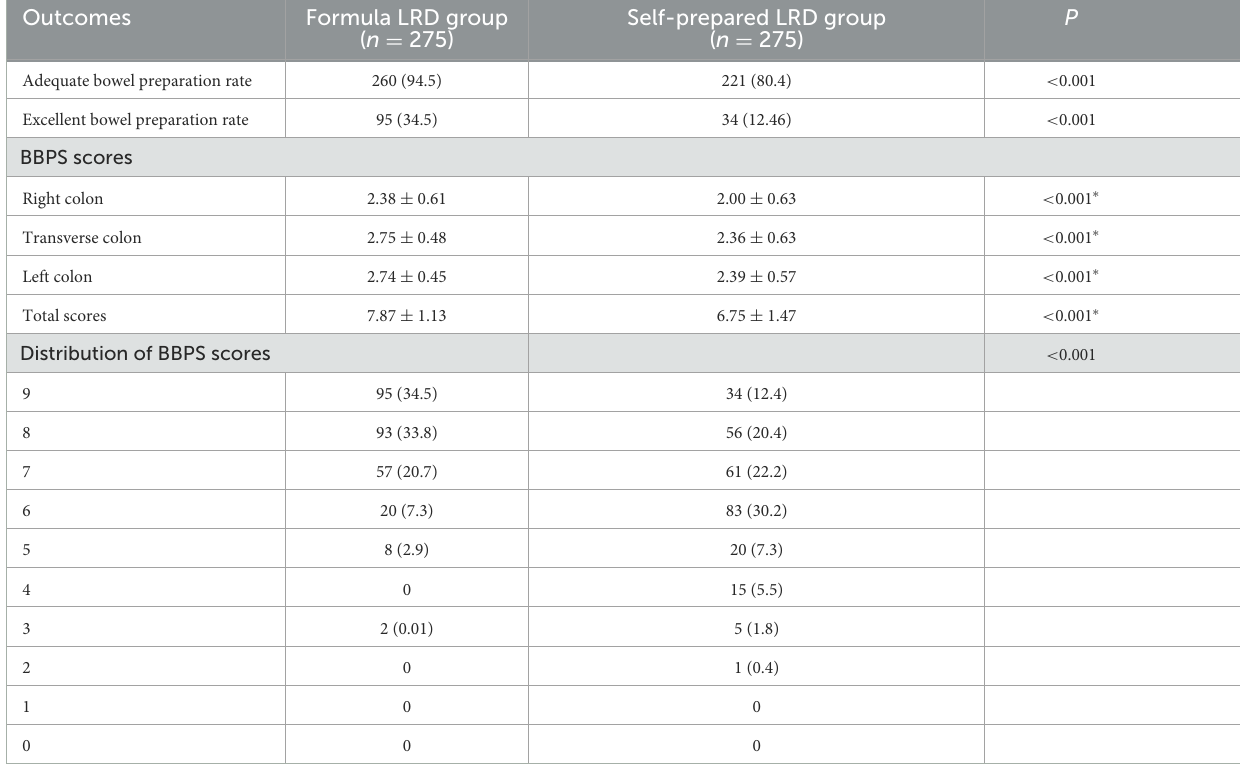
TABLE 2 Comparison of quality of bowel preparation by ITT analysis.